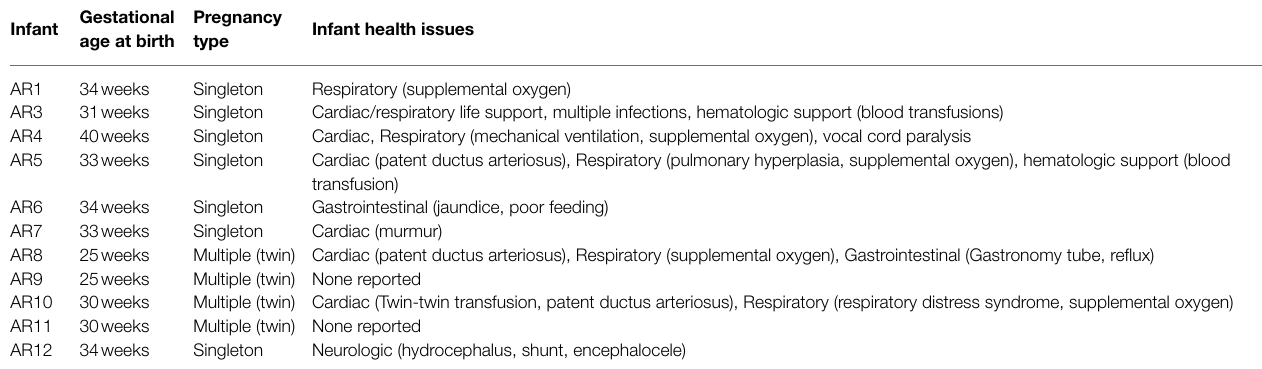
TABLE 1 | Description of at risk (AR) participants.